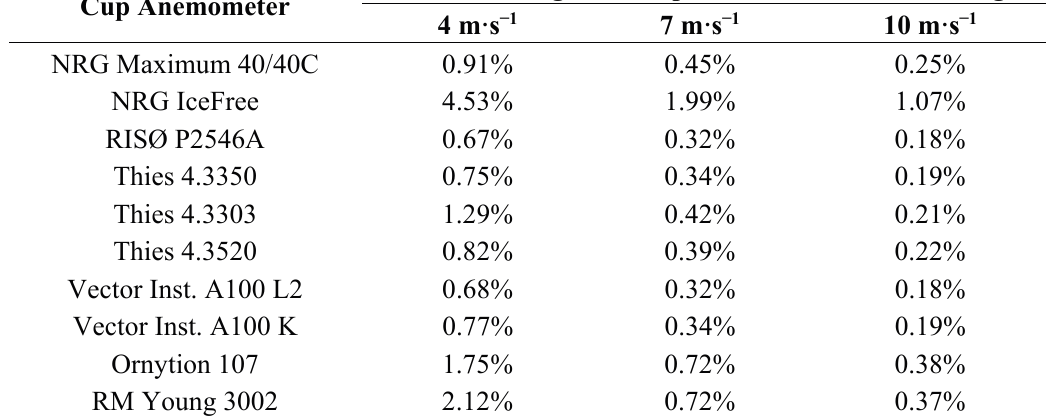
Table 1. Percentage variation in the Annual Energy Production (AEP) of a